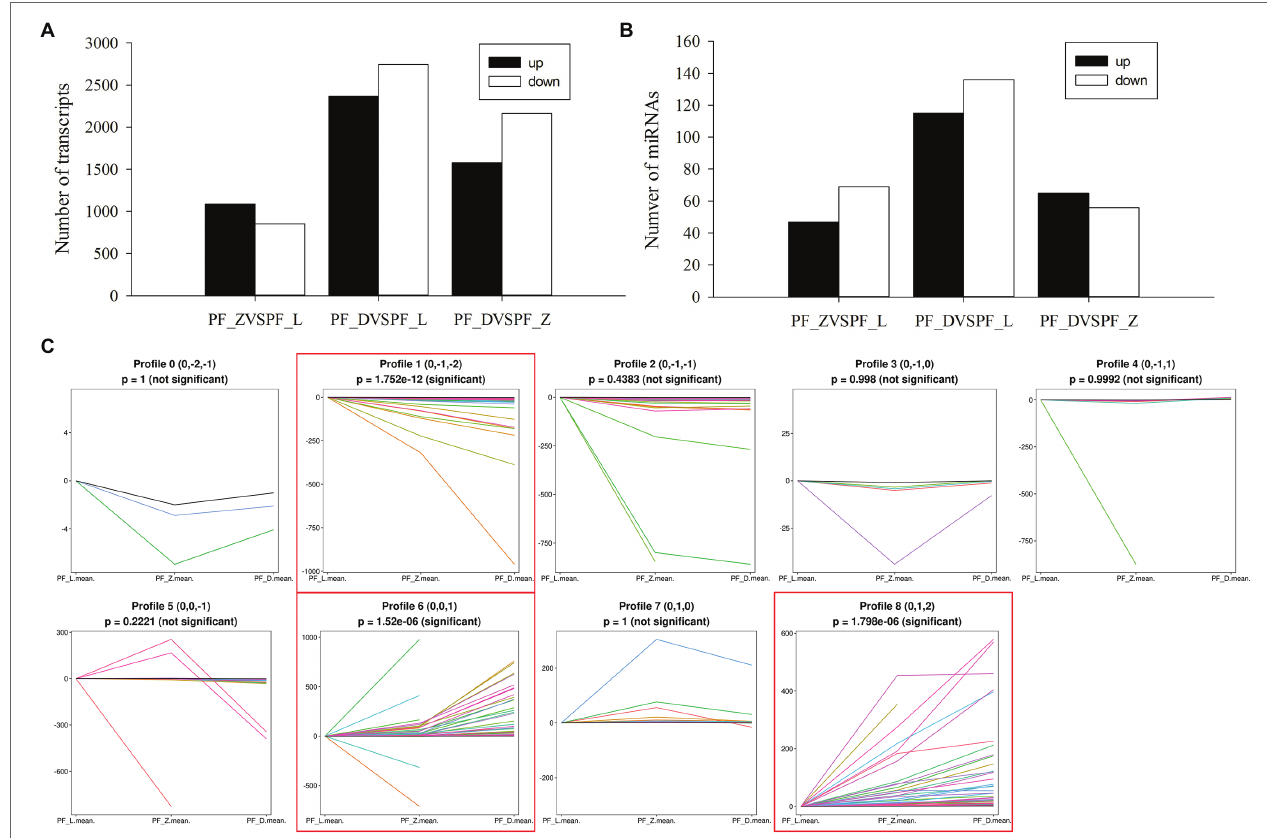
FIGURE 2 | Overview of differentially expressed miRNAs and genes generated via high-throughput sequencing of the nine libraries in pink-flowered strawberry. (A) The numbers of differentially expressed transcripts in the various comparisons among PF_L, PF_Z, and PF_D. (B) The numbers of differentially expressed miRNAs in the various comparisons among PF_L, PF_Z, and PF_D. (C) Expression patterns of differentially expressed miRNAs during flower development from profile 0 to 8. Only profiles 1, 6, and 8 showed significantly different trends ( p <